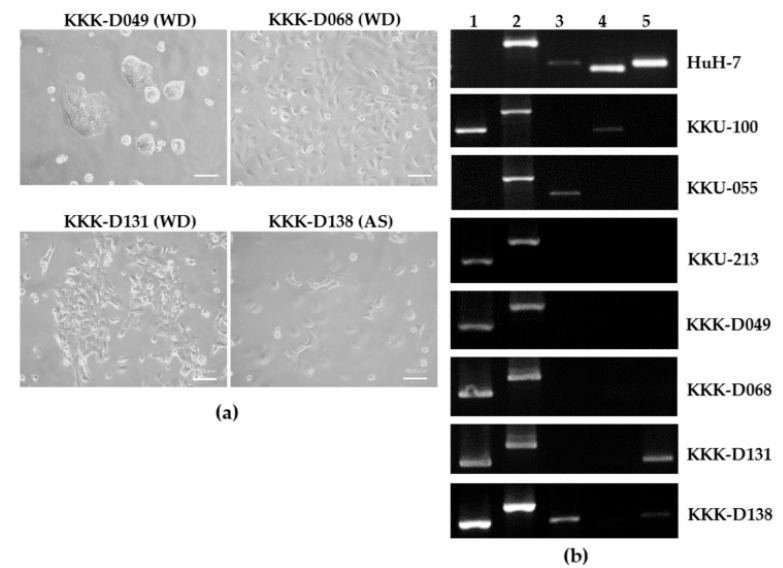
Figure 4. The morphologies ( a ) and gene expression profile ( b ) of PDX-derived CCA cell lines KKK-D-49, KKK-D068, KKK-D131, and KKK-D138. Huh7, KKU-100, KKU-055, and KKU-213 were used as references. WD: well di ff erentiated subtype; AS: adenosquamous subtype; 1: cytokeratin 7 (CK7); 2: CK19, 3: γ -glutamyl transferase (GGT); 4: α -fetoprotein (AFP); 5: albumin